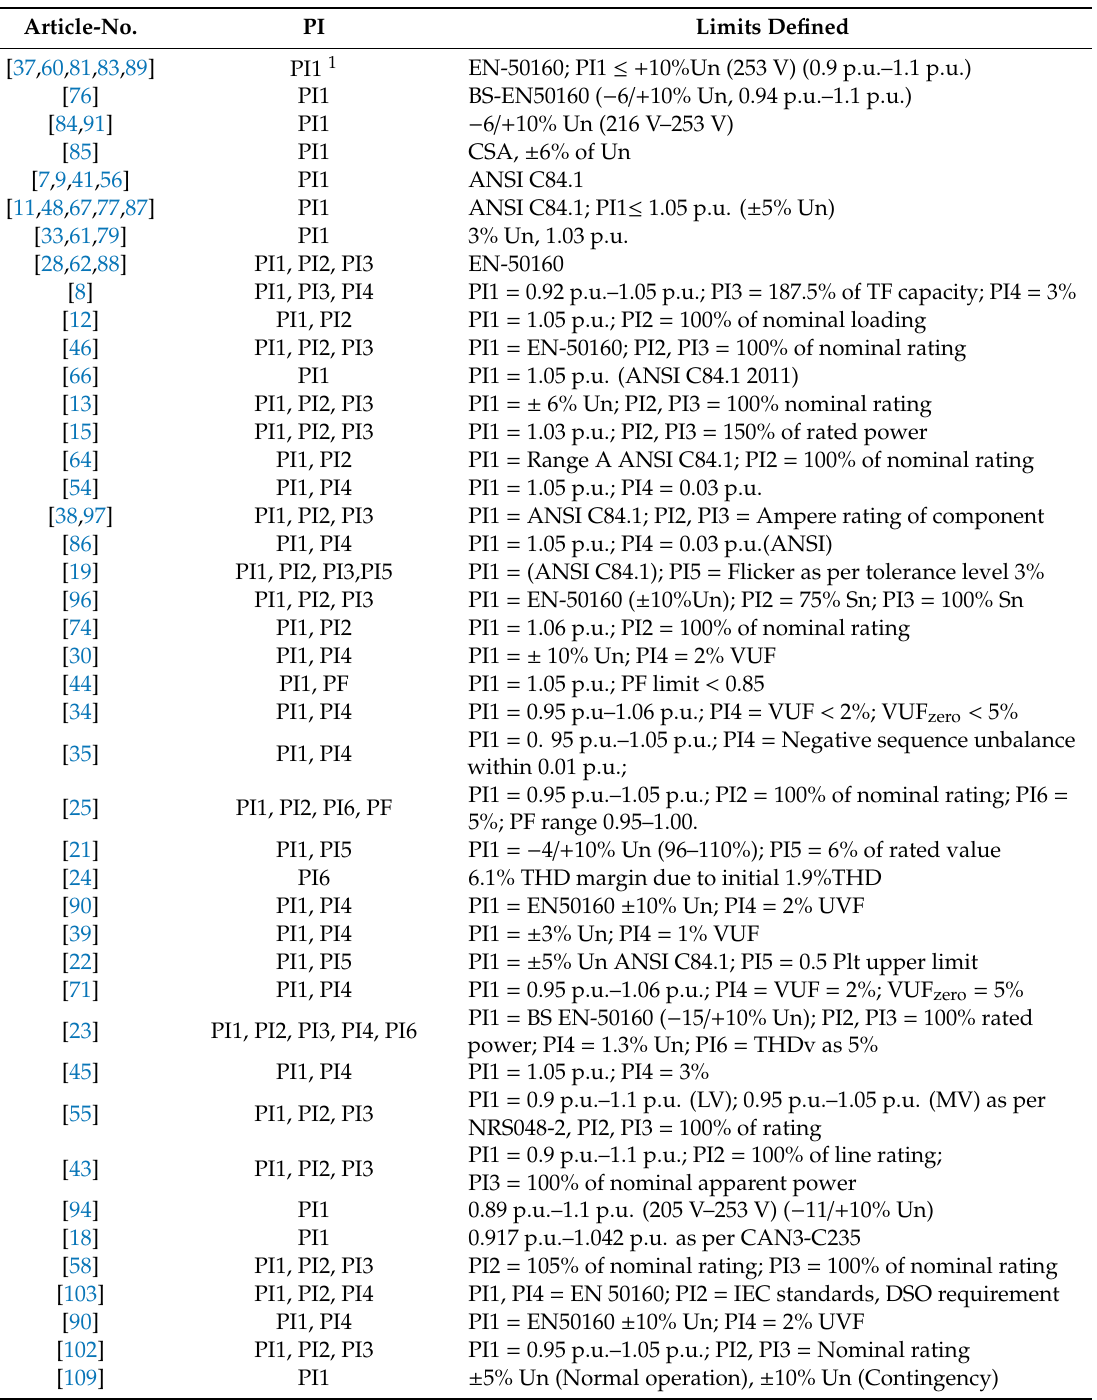
1 : PI1 = Voltage Violations, PI2 = Cable Ampacity, PI3 = Transformer Overloading, PI4 = Voltage Unbalance, PI5 = Flicker, PI6 =